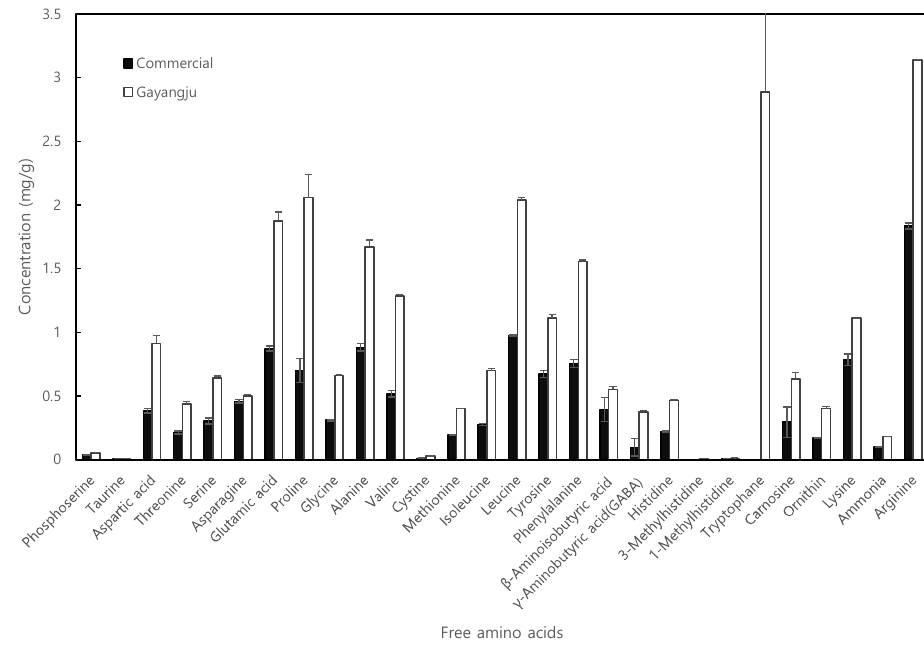
Figure 3. Free amino acids analysis of Gayangju and the commercial rice wine makgeolli .